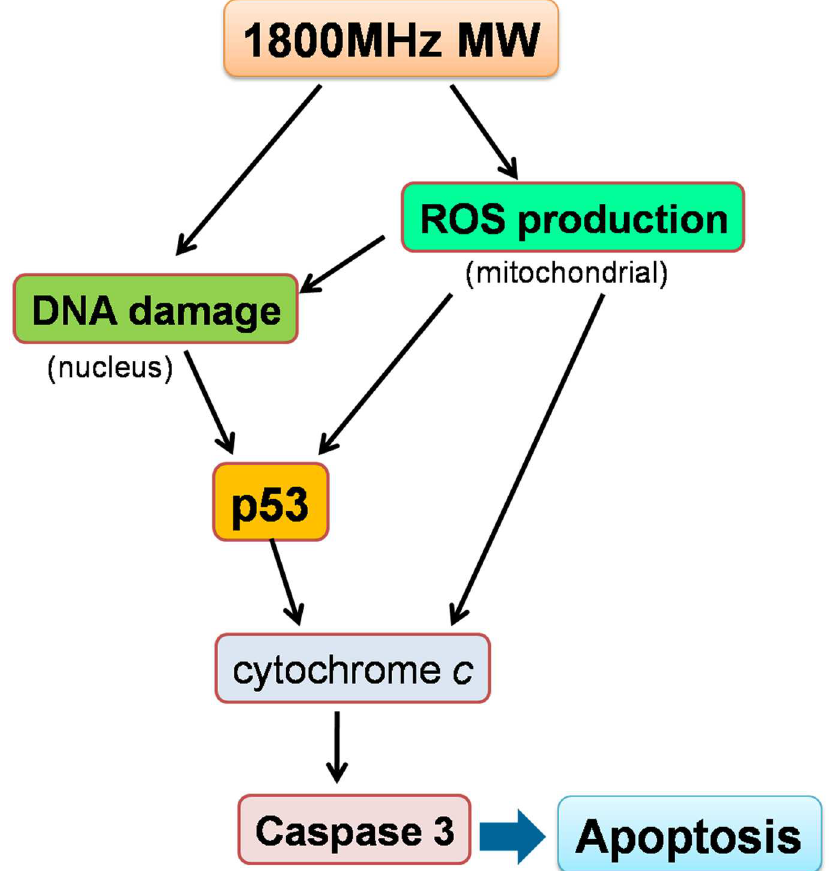
Fig 7. Schematic representation of p53 activation of caspase-3signaling pathway in 1800MHz microwave induced cell apoptosis. 1800MHzmicrowave activates p53 signalingpathway through enhancing ROS productionand DNA damage, p53 further upregulates cytochrome c -mediated caspase-3 activation that leads to cell apoptosis. MW, microwave; NAC, N-acetyl-L-cysteine; ROS, reactive oxygen